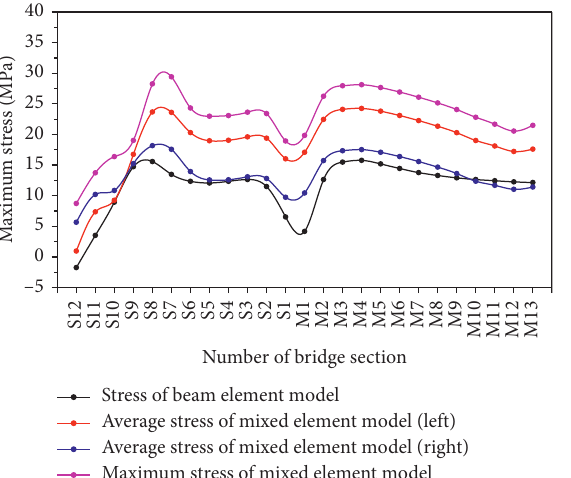
Figure 22: The calculated stress value of the bottom plate of the steel girder in both the beam element model and the mixed element model in Figures 23 and 24. The maximum shear stress on the in- terface was about 0.25 MPa, which appeared near the in- terface position corresponding to the beam (the beam corresponding to the anchorage cable), namely, position 2 in Figure 25. The maximum tensile stress on the interface was about 0.68–0.74 MPa, which appeared at the interface po- sition corresponding to the beam (the beam corresponding to the anchorage cable), namely, position 2 in Figure 25. The